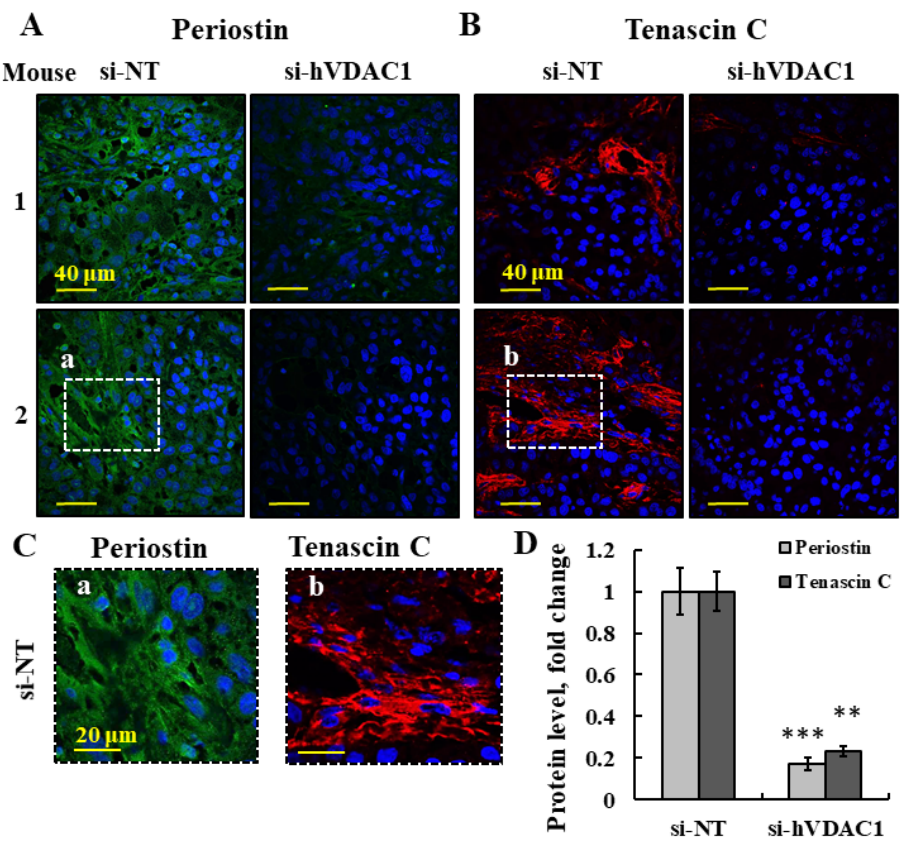
Figure 4. IF analysis of periostin and tenascin C expression in si-NT-TTs and si-hVDAC1-2A-TTs. ( A , B ) Representative IF staining using specific antibodies against periostin and tenascin C derived from A549 xenografts in si-NT-TT and si-hVDAC1-2A-TT sections. In ( C ), an enlargement of the area ( a , b ) in ( A , B ), respectively, is shown. ( D ) Quantitative analysis of fluorescence intensity in ( A , B ). The results are the means ± SD, ** p ≤ 0.01, * ** p ≤ 0.001. Furthermore, according to the TCGA database, lung cancer patients with elevated serum levels of periostin have a significantly lower overall survival rate than patients with low serum periostin levels (Figure S2A). The same correlation was also found with serum tenascin C, where high levels in the serum were linked to poor overall survival probability (Figure